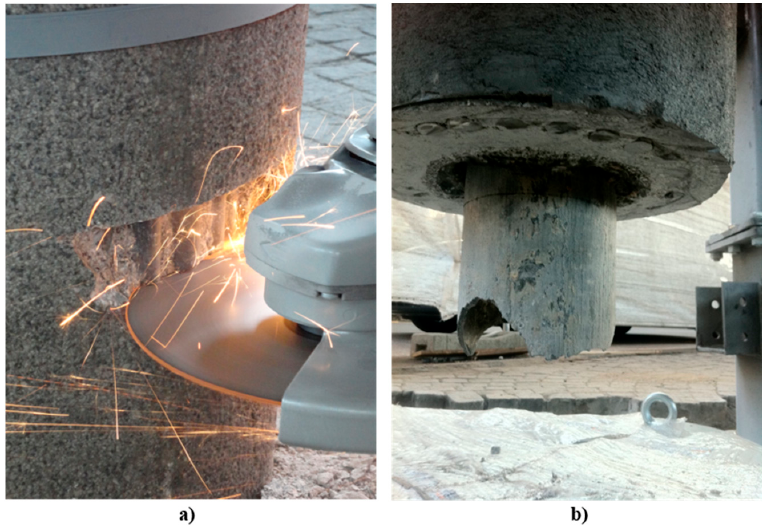
Figure 11. Cutting operations of the ground floor columns: ( a ) cut of the existing longitudinal rein- forcing steel bars by a diamond-headed saw, and ( b ) hollow column with sewage duct after cut- ting.